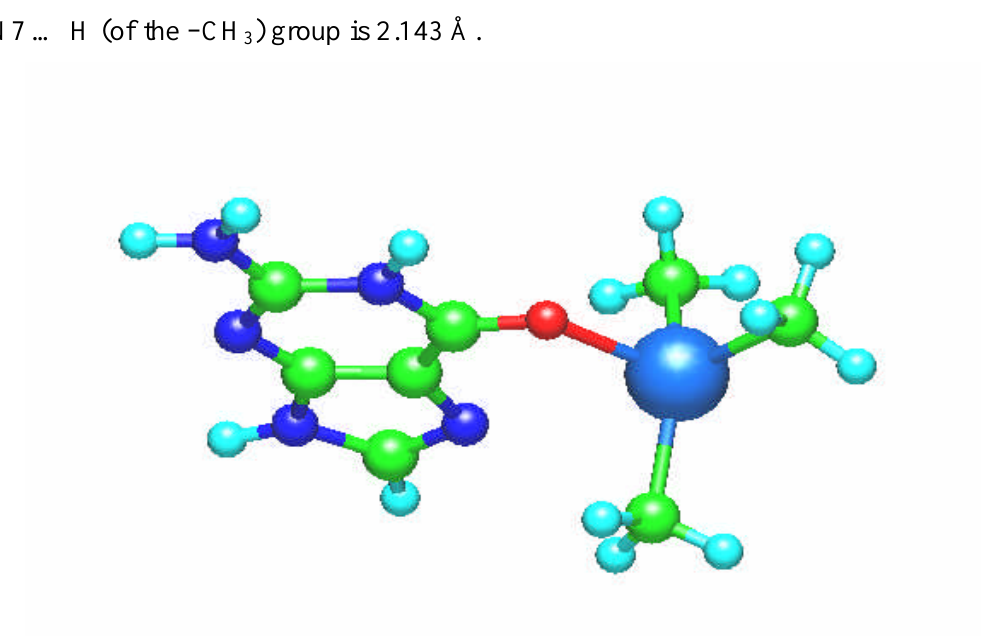
Fig. 5. Molecular structure of the [Sn(NH